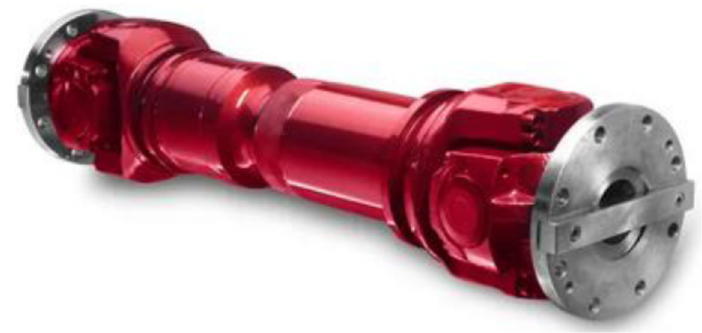
Figure 2. Industrial double cardan driveshaft.